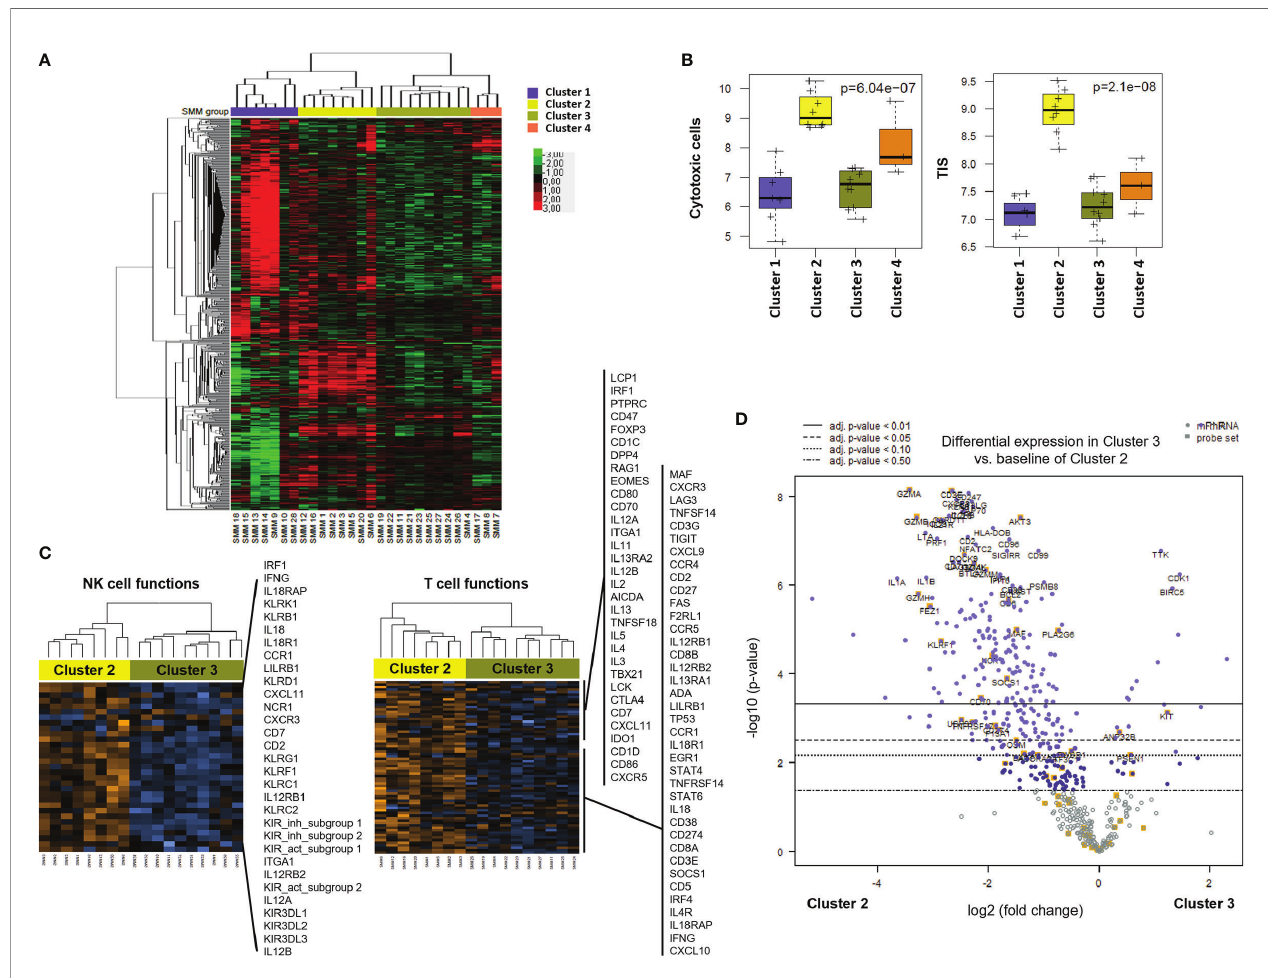
FIGURE 4 | Gene pro fi ling of bone marrow cells identi fi ed distinct clusters in patients with SMM based on immune cell composition and activation markers. (A) Heatmap showing the unsupervised hierarchical clustering of patients with SMM (n=28) based on the NanoString PanCancer Immune panel. (B) Statistical analysis of gene set associated to cytotoxic cells and the tumor in fl ammation signature (TIS) in the 4 distinct clusters of patients with SMM. (C) Heatmaps of genes associated to NK and T cell functions comparing cluster 2 versus 3. (D) Volcano plot showing genes differentially expressed in cluster 2 versus cluster